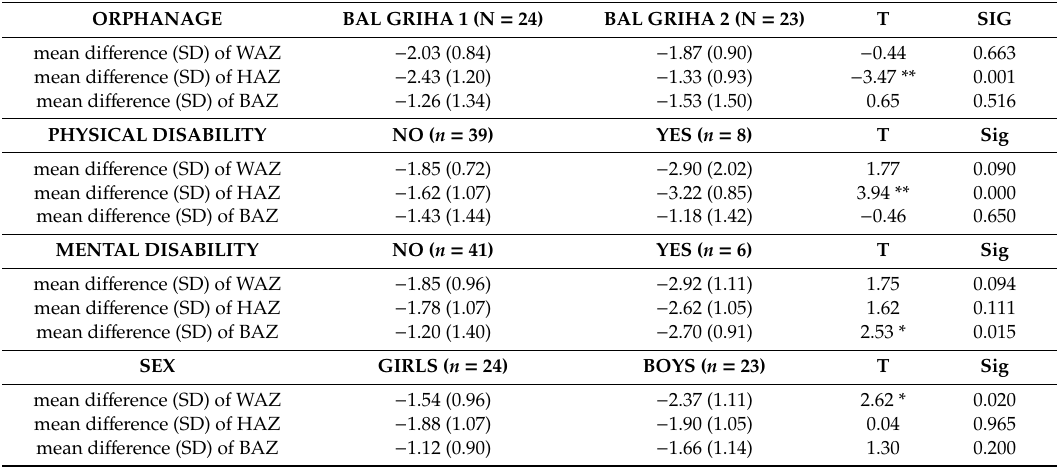
Table 2. Mean di ff erence (and standard deviation; SD) for WAZ, HAZ, and BAZ compared with the WHO’s standard for age and grouped by orphanage, physical disability, mental disability, and sex. ORPHANAGE BAL GRIHA 1 (N = 24) BAL GRIHA 2 (N = 23) T SIG mean di ff erence (SD) of WAZ − 2.03 (0.84) − 1.87